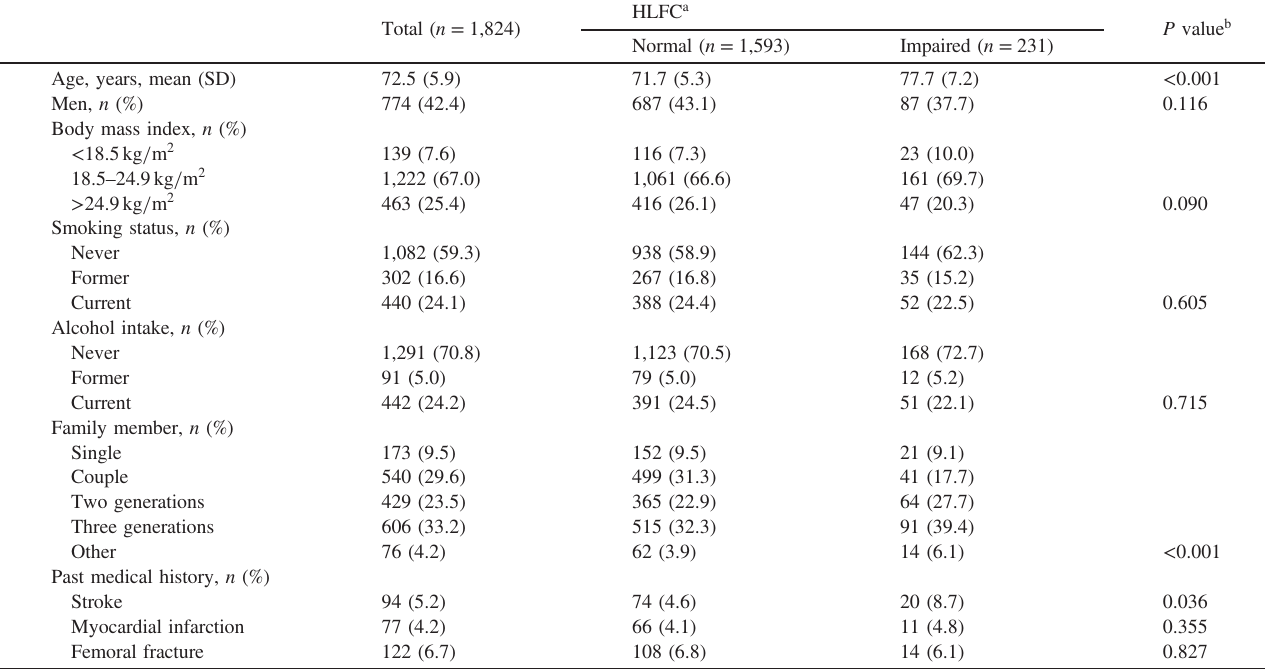
Table 1. Baseline characteristics, NIPPON DATA90, in